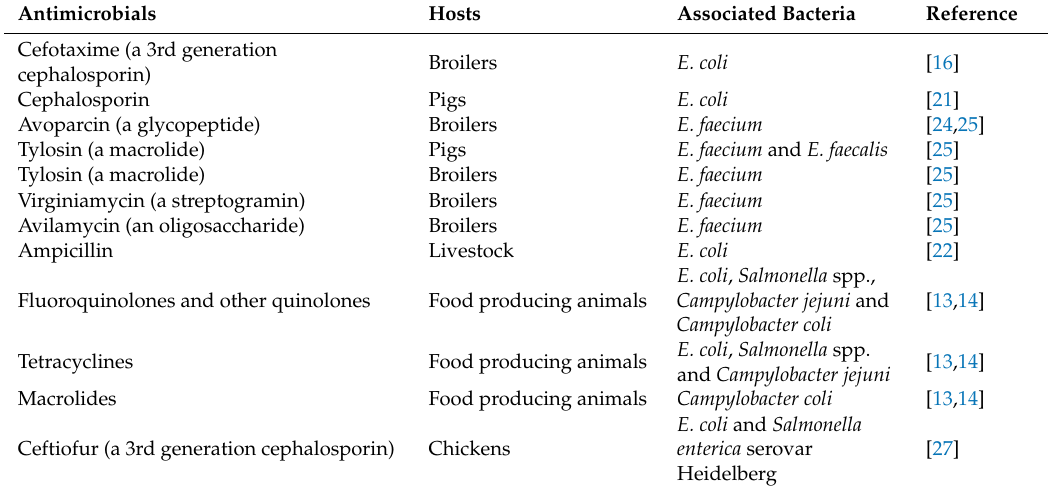
Table 1. Examples of associations between the use of some antimicrobials and resistance to these antimicrobials in specific